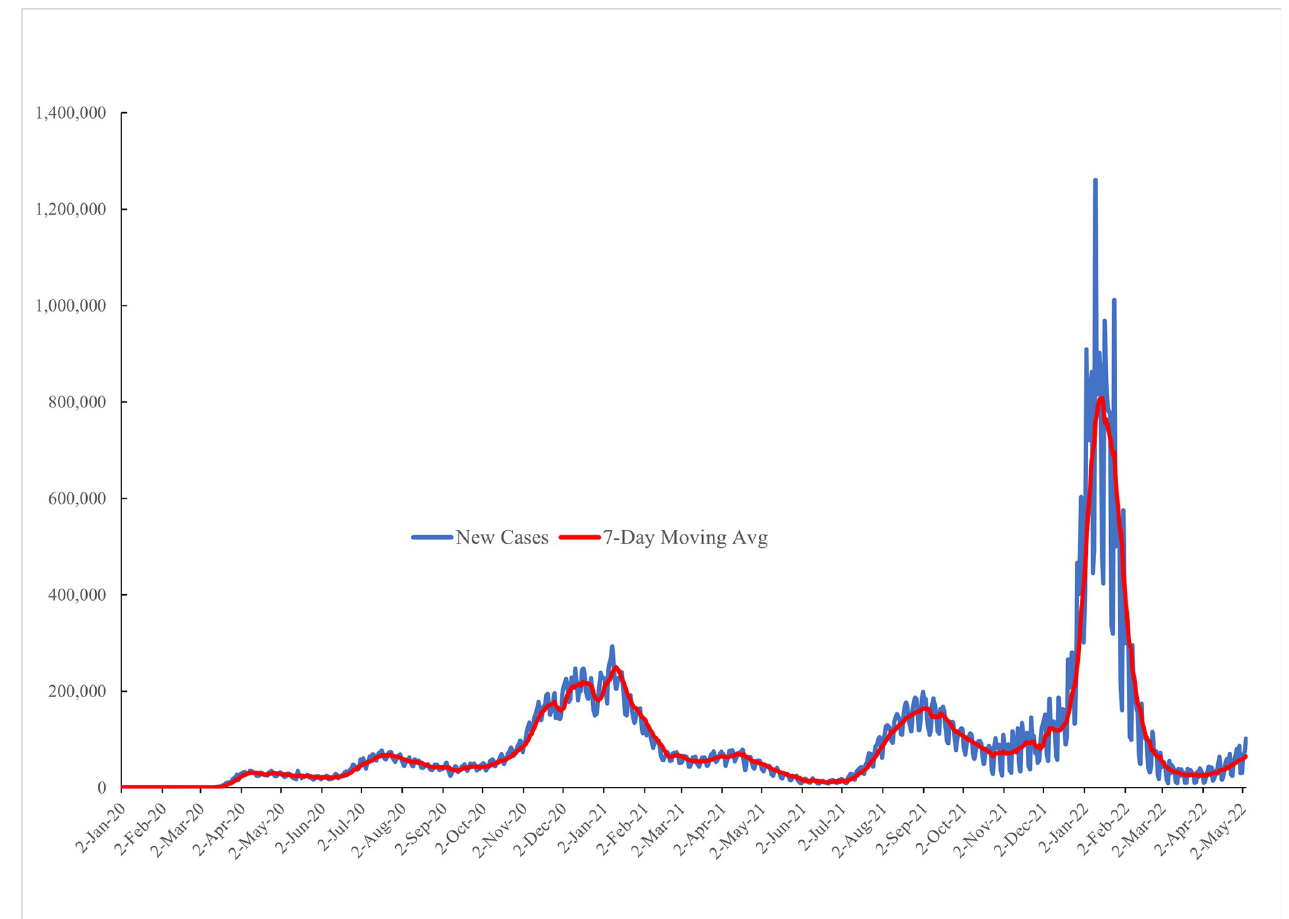
Fig 2. Daily cases reported to CDC 2nd January 2020-4th May